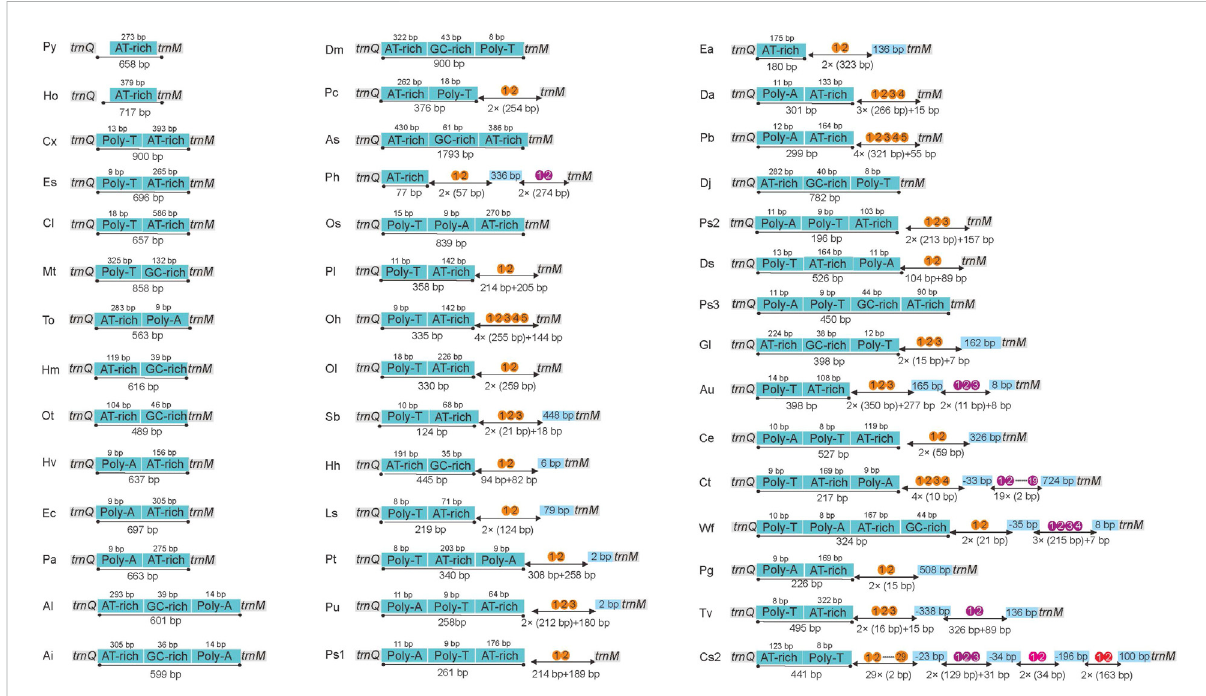
FIGURE 6 Organization of the control regions in the RTA mitochondrialgenomes. The location and copy number of tandem repeats are shown inorange andthreedifferentdepthsofredwitharabicnumbersinside.Theboxescoloredskybluerepresentintervalsequences(positivenumbers)oroverlaps (negative numbers) between two elements.